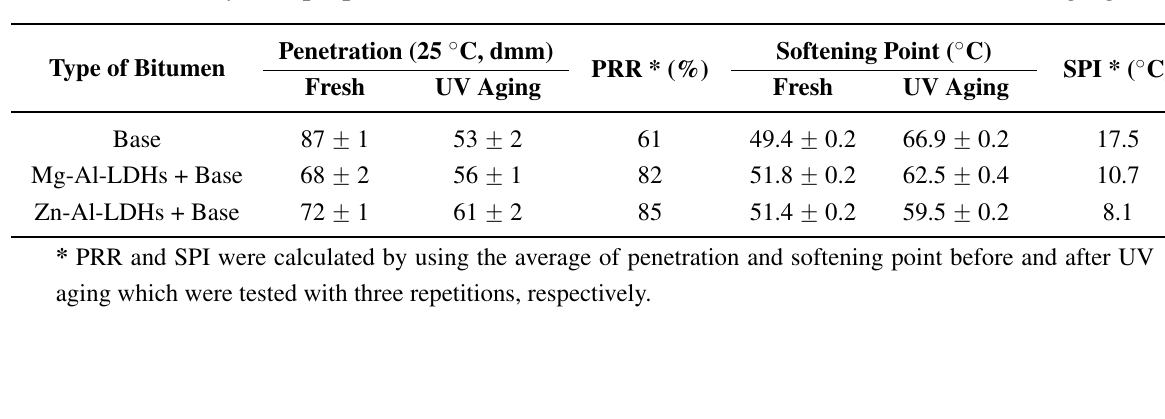
Table 4. Physical properties of base and modified bitumens before and after UV